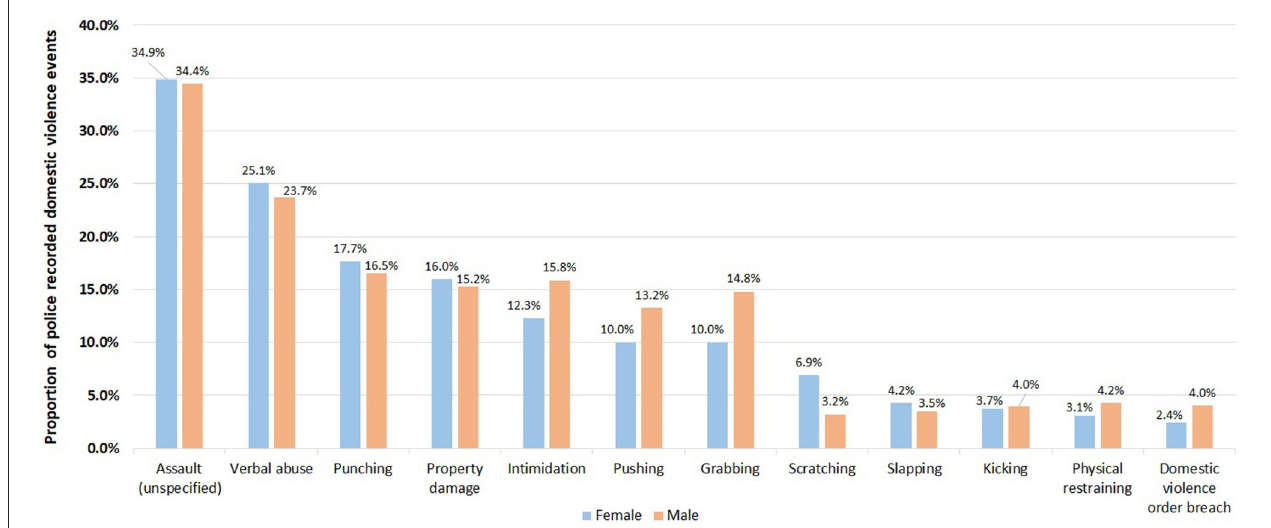
FIGURE 7 | Comparison of proportions of abuse types (top 10 only) for male and female POIs in 416,441 police recorded domestic violence events in NSW, January 2005–December 2016.